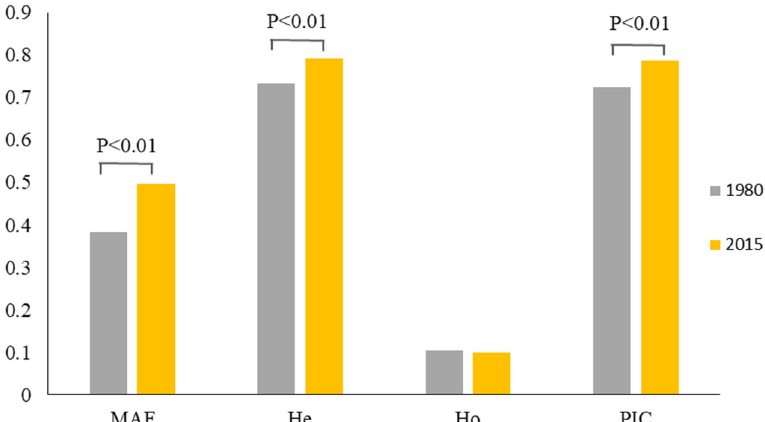
Figure 5. Comparison of the genetic diversities between populations collected in 1980 and 2015. MAF, major allele frequency; He , gene diversity; Ho , heterozygosity; and PIC, polymorphic information content.